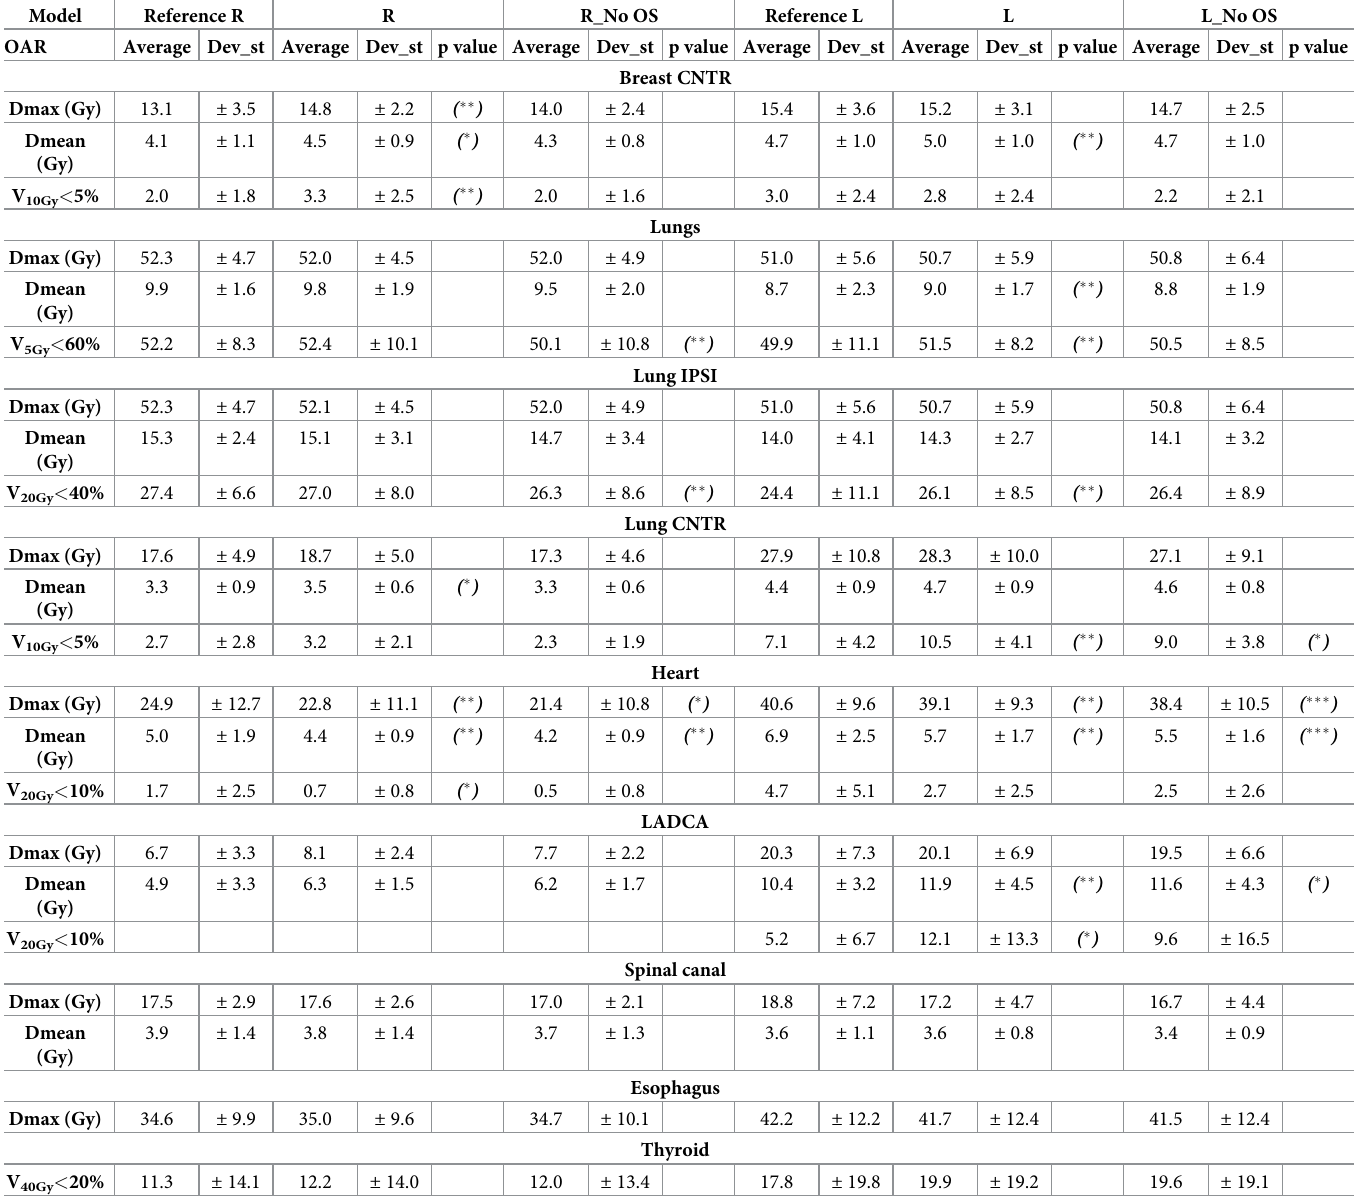
Table 3. Overview and comparison of relevant DVH parameters for OARs, averaged for the 18 patients of validation set, treated on the right side and for the 12 patients treated on the left side, both for reference and model-based plans.